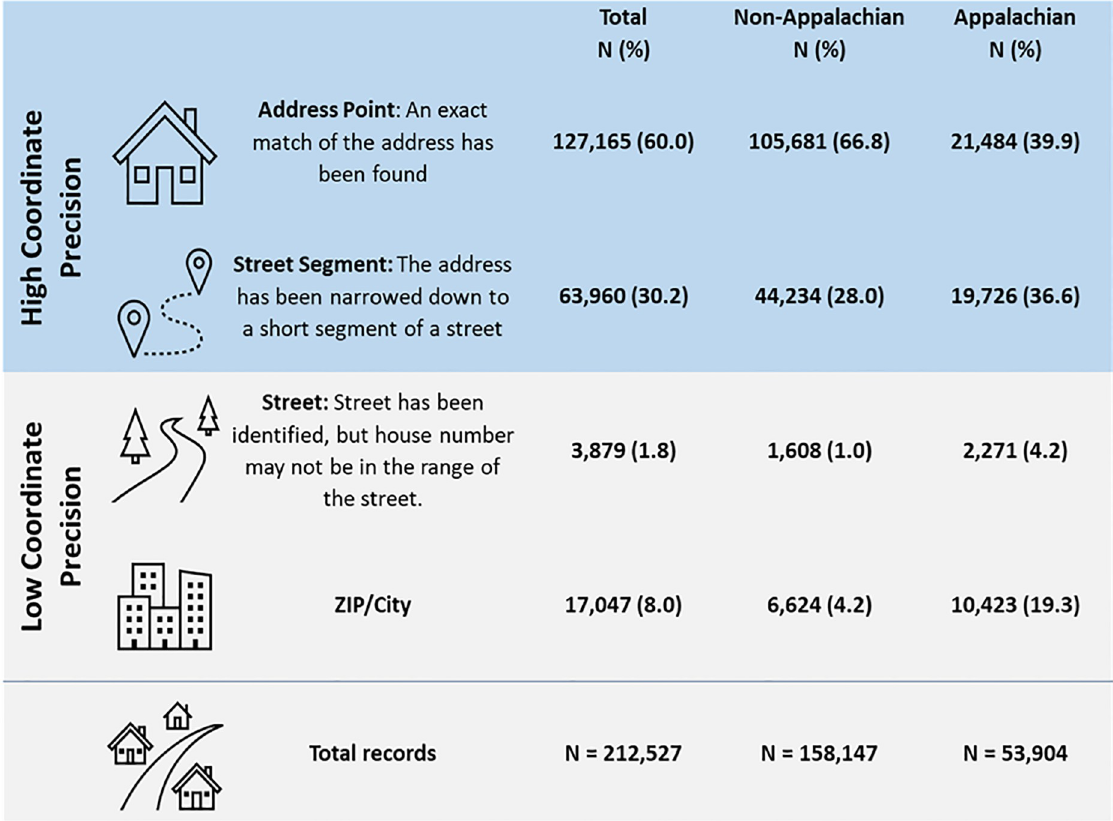
Fig 1. Description and summary of geocoding precision for Kentucky addresses,